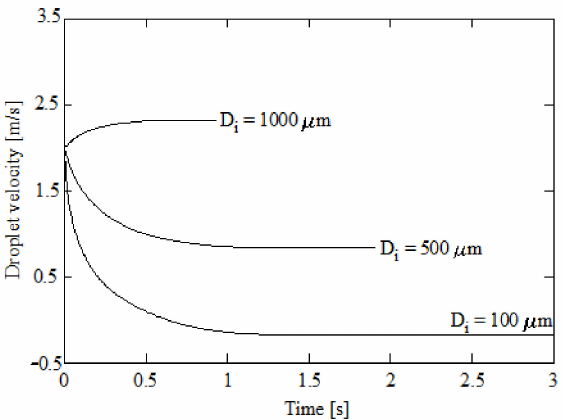
Figure 7. Droplet velocity against time for several initial diameters; 5% initial ammonia concentration, 100 ◦ C initial gas temperature, and 5 ◦ C initial liquid